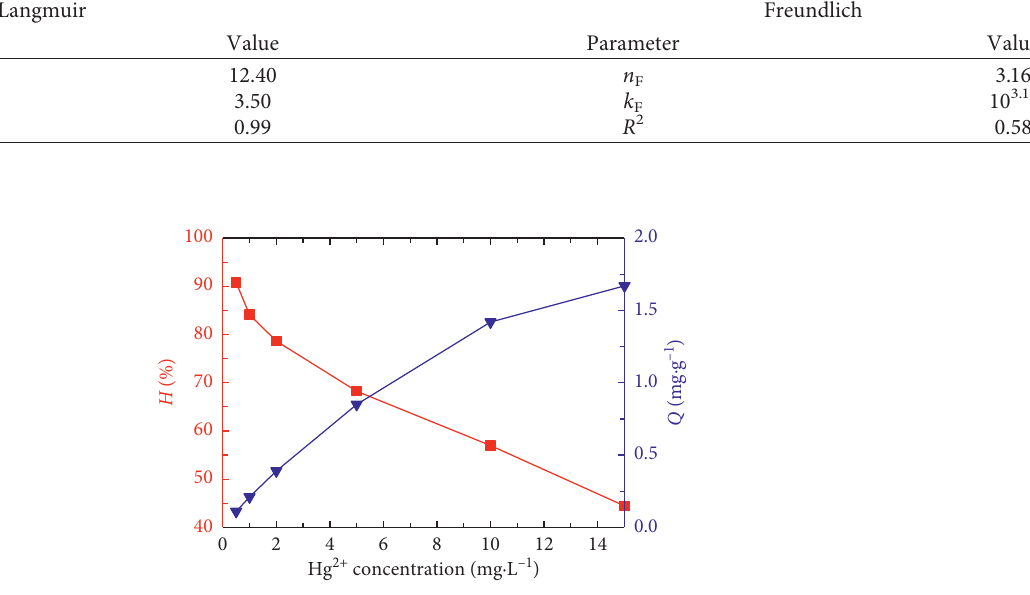
Figure 10: Influence of percent removal of Hg 2+ ion H (- ■ -) and amount of adsorbed Hg 2+ ion at equilibrium conditions Q (- ▲ -) on initial Hg 2+ concentration (adsorbent of FAMBT). Table 6: Langmuir and Freundlich isotherm parameters reflecting Hg 2+ ion adsorption by the FAMBT particles.